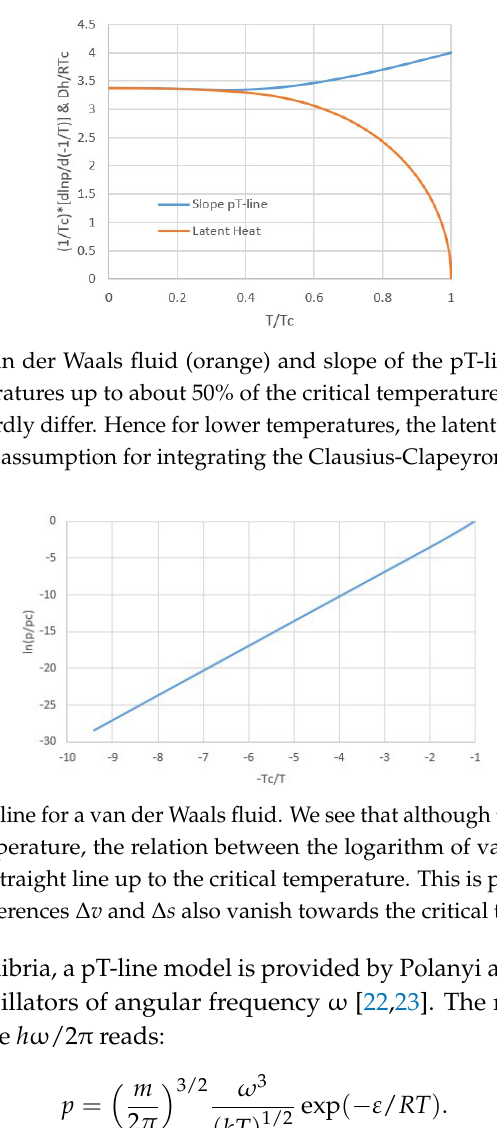
heat may be considered constant, confirming Equation (1) for vapor-sorbed equilibria as well.